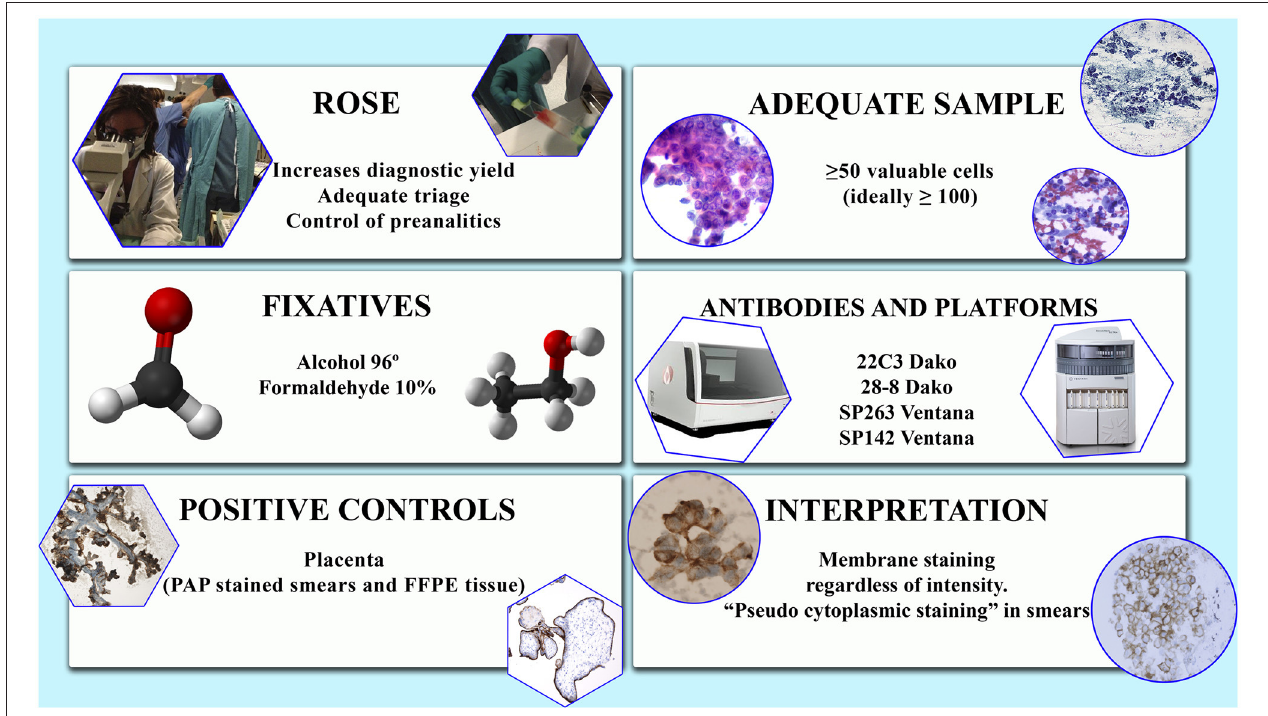
FIGURE 1 | Some issues to be considered in the study of PD-L1 in cytological samples. Factors to be